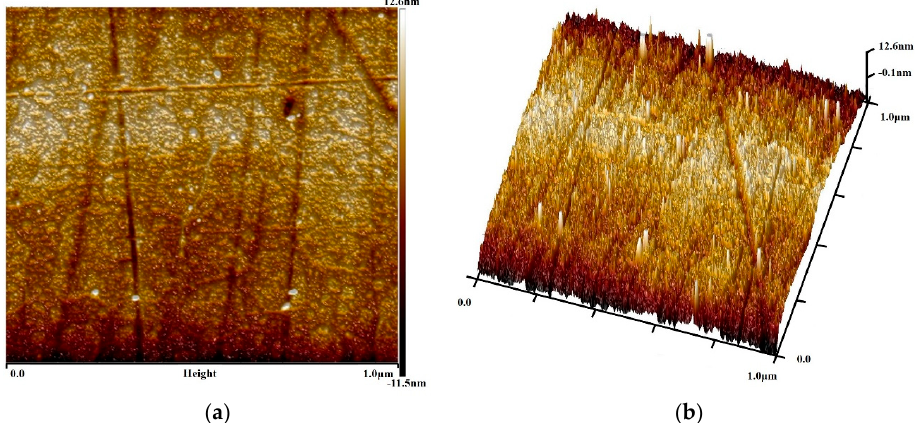
Figure 7. AFM ( a ) 2D and ( b ) 3D images of untreated albite.